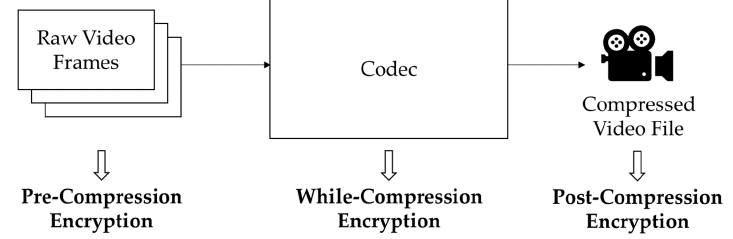
Figure 2. Classification of permutation-based video encryption algorithms.